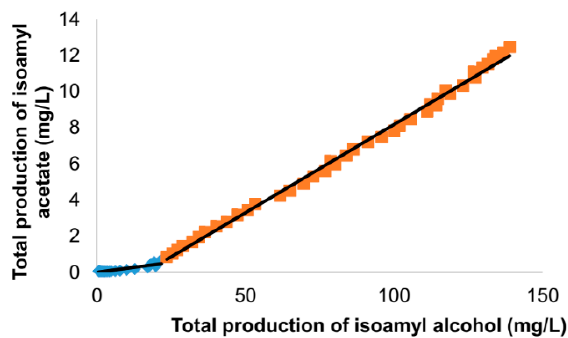
Figure 3. Online GC monitoring of fermentation aromas in 100 L tanks. Focus on the bioconversion of isoamyl alcohol to isoamyl acetate. Changes in total isoamyl acetate production as a function of total isoamyl alcohol production. The total productions represent the sum of the concentration in the liquid and the amount lost in the gas phase.